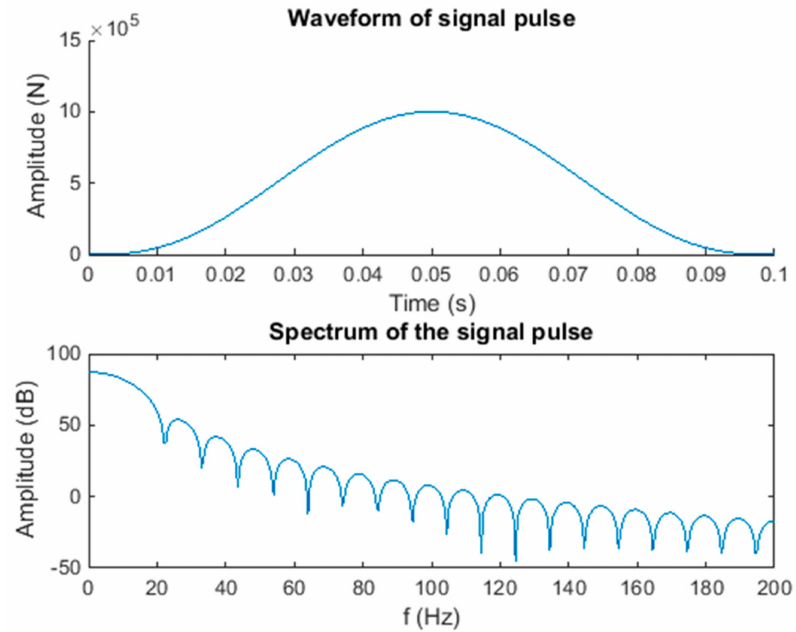
Figure 4. Source signal waveform and